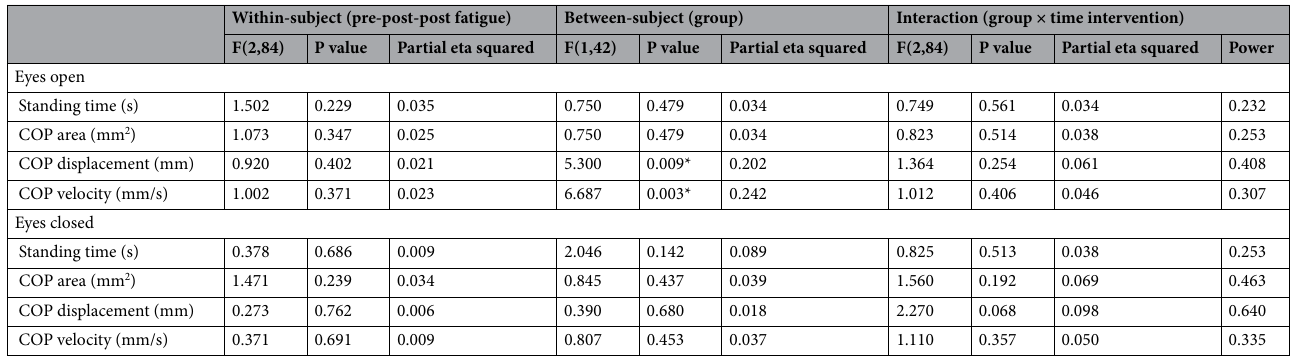
Table 2. Statistical results of the balance data among the three groups on barefoot with eyes open and closed eyes condition. * p < .05.